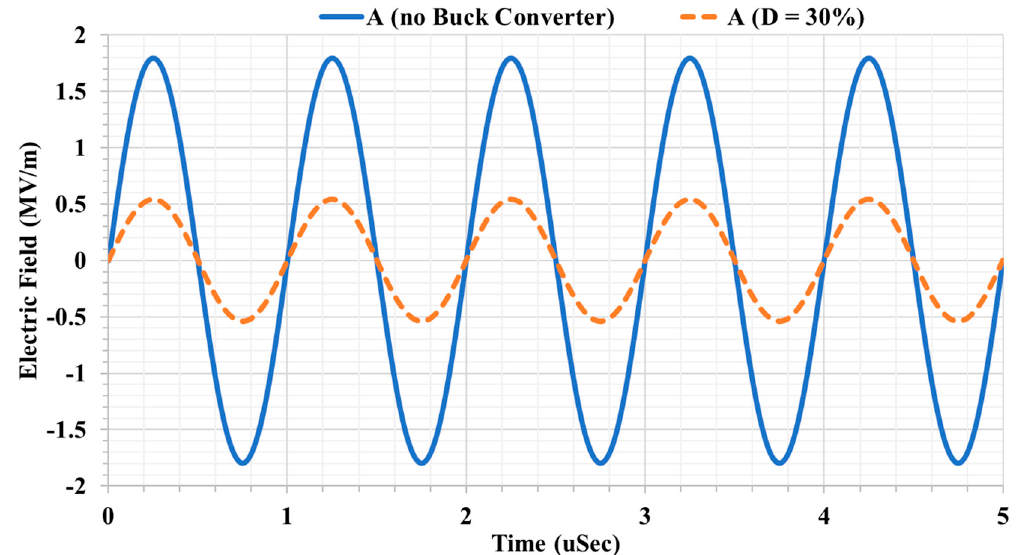
Figure 10. Simulated electric field at measure point A between Tx1 and Rx1.